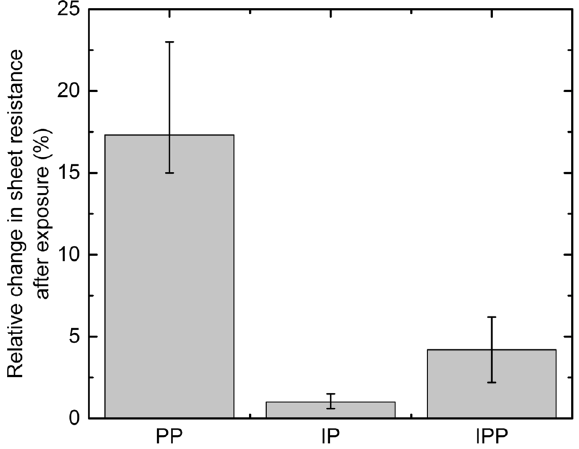
Fig. 8 Variations of average sheet resistance after exposure to environment (80% RH, 50